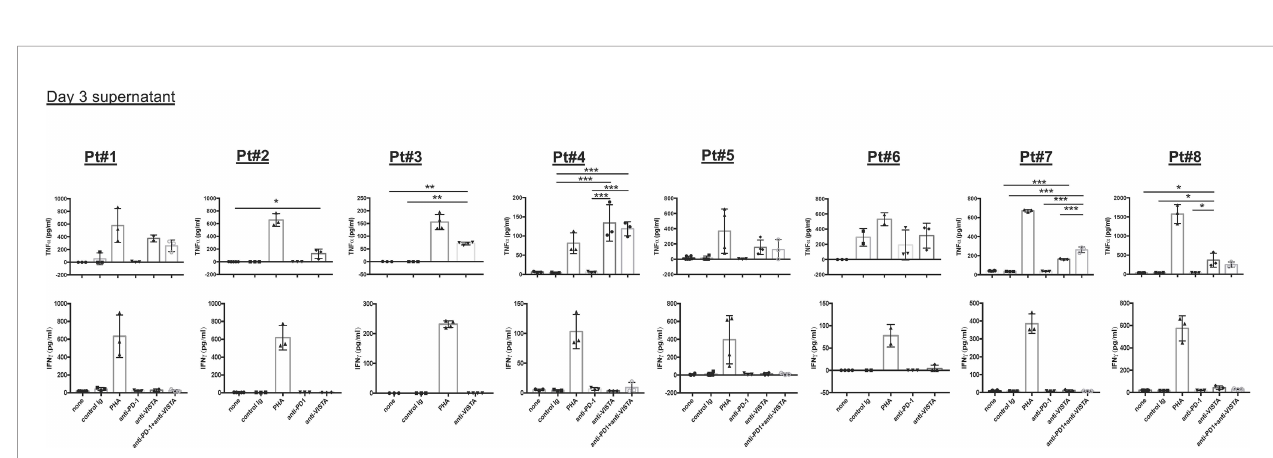
FIGURE 5 | Blockade of VISTA enhanced TNF- a secretion in all tested clear cell renal cell carcinoma (ccRCC) patients. (A) Fresh tumor slices from ccRCC patients were stimulated with blocking or control antibodies. Culture supernatants were collected after 48 h Levels of TNF- a and IFN- g were analyzed by ELISA. TNF- a and IFN- g secretion on day 2 is shown. (B) TNF- a secretion induced by anti-VISTA or anti-PD-1 on day 2. (C) Kinetics of TNF- a responses induced by anti-VISTA or PHA. * p < 0.05, ** p < 0.01, *** p < 0.001. ns, not signi fi cant.